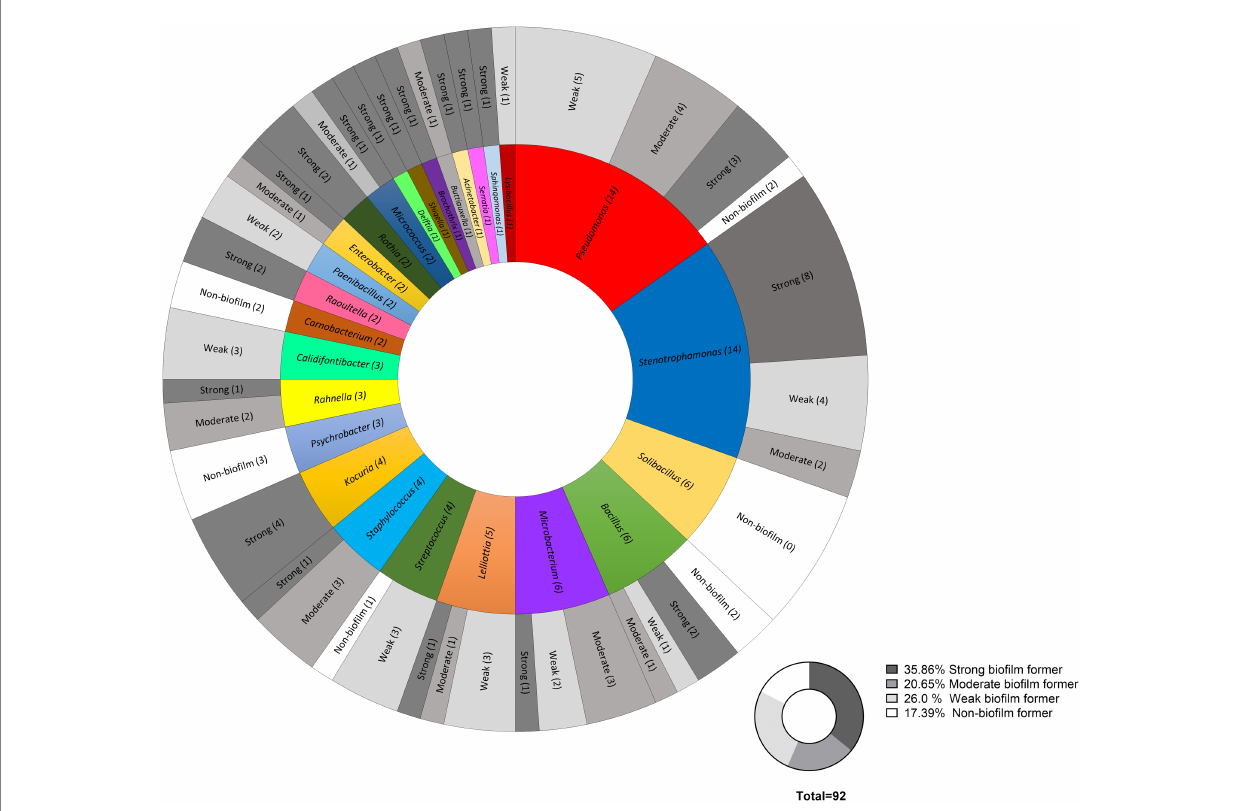
FIGURE 2 Classification of the biofilm-forming ability of the total strains at the genus level from food contact surfaces of three food industries (dairy, meat, and egg processing) after cleaning and disinfection into non-biofilm formers, weak biofilm formers, moderate biofilm formers, and strong biofilm formers based on their OD values. The cutoff OD (ODc) was defined as three SDs above the mean OD of the negative control (Abs 590 : 0.17). Biofilm forming potential was determined as follows: OD ≤ ODc = non-biofilm former, ODc < OD ≤ (2 × ODc) = weak biofilm former, 2 × ODc < OD ≤ 4 × ODc = moderate biofilm former and 4 × ODc < OD = strong biofilm